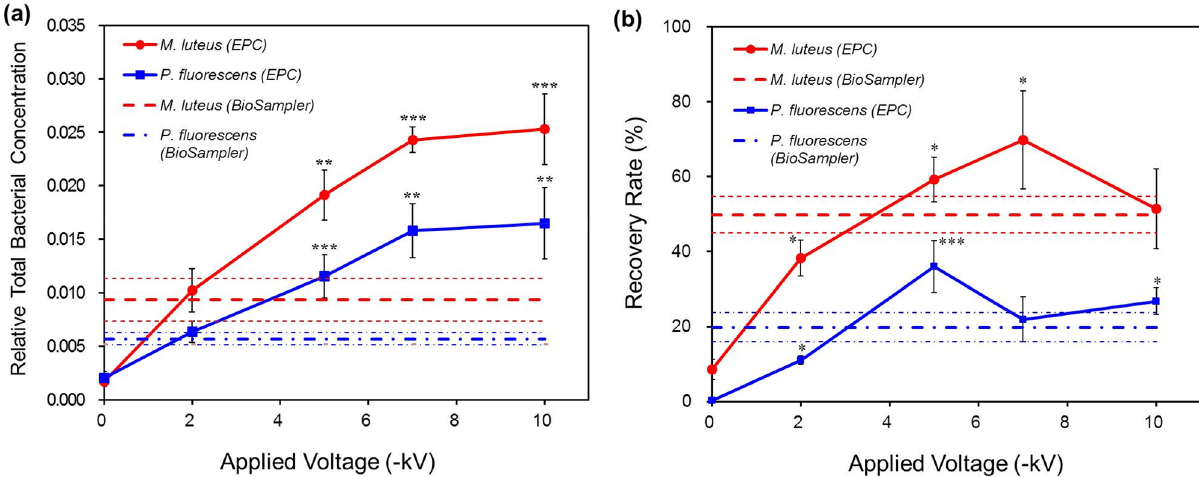
Figure 5. Relative total bacterial concentrations ( a ) and recovery rates ( b ) of P. fluorescens and M. luteus in the EPC with different applied voltages (from 0 to − 10 kV) and in the BioSampler with a sampling medium of 0.01% sodium dodecyl sulfate. The thinner horizontal lines represent standard deviations of the respective average values in the BioSampler. The statistical differences between the values in the EPC and those in the BioSampler were indicated as asterisks (* p < 0.05, ** p < 0.005, *** p <